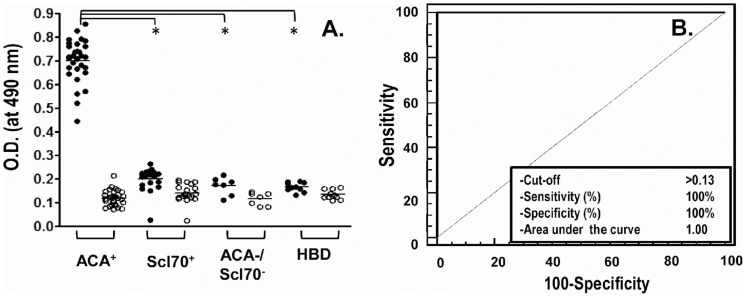
Screening of SSc sera for specificity to Ap1-17.(A.) Sera from SSc patients (30 ACA+, 20 Scl70+; 7 ACA−/Scl70−) were screened for specificity to Ap1-17 peptide in an indirect ELISA. Microtiter plates were coated with 5 µg/ml KLH-conjugated Ap1-17 (filled circles) or KLH-conjugated Qp1-a (open circles). Wells were incubated for 4 h with serum samples (diluted 1∶100) from the three groups of patients and from 10 healthy blood donors (HBD); samples were tested in duplicate. Bound IgG was revealed with HRP-conjugated anti-human IgG (Fc portion) and o-phenylenediamine. Each data point is the mean of duplicate wells (SEM ≤8%). Horizontal lines indicate the mean for each group. O.D., optical density. *Mann-Whitney p<0.0001. (B) ROC analysis was performed by including the absorbance binding of each patient's serum to Ap1-17 (minus the absorbance of the same sera to the unrelated peptide Qp1-a) as variable, and by comparing the ACA+ group to control ACA− group.